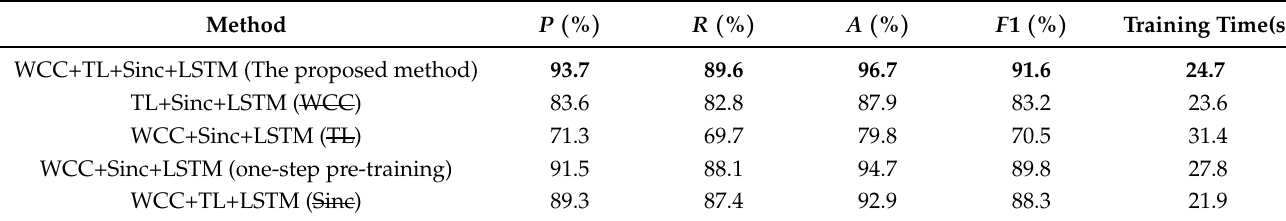
Table 2. Self contrast experiments.